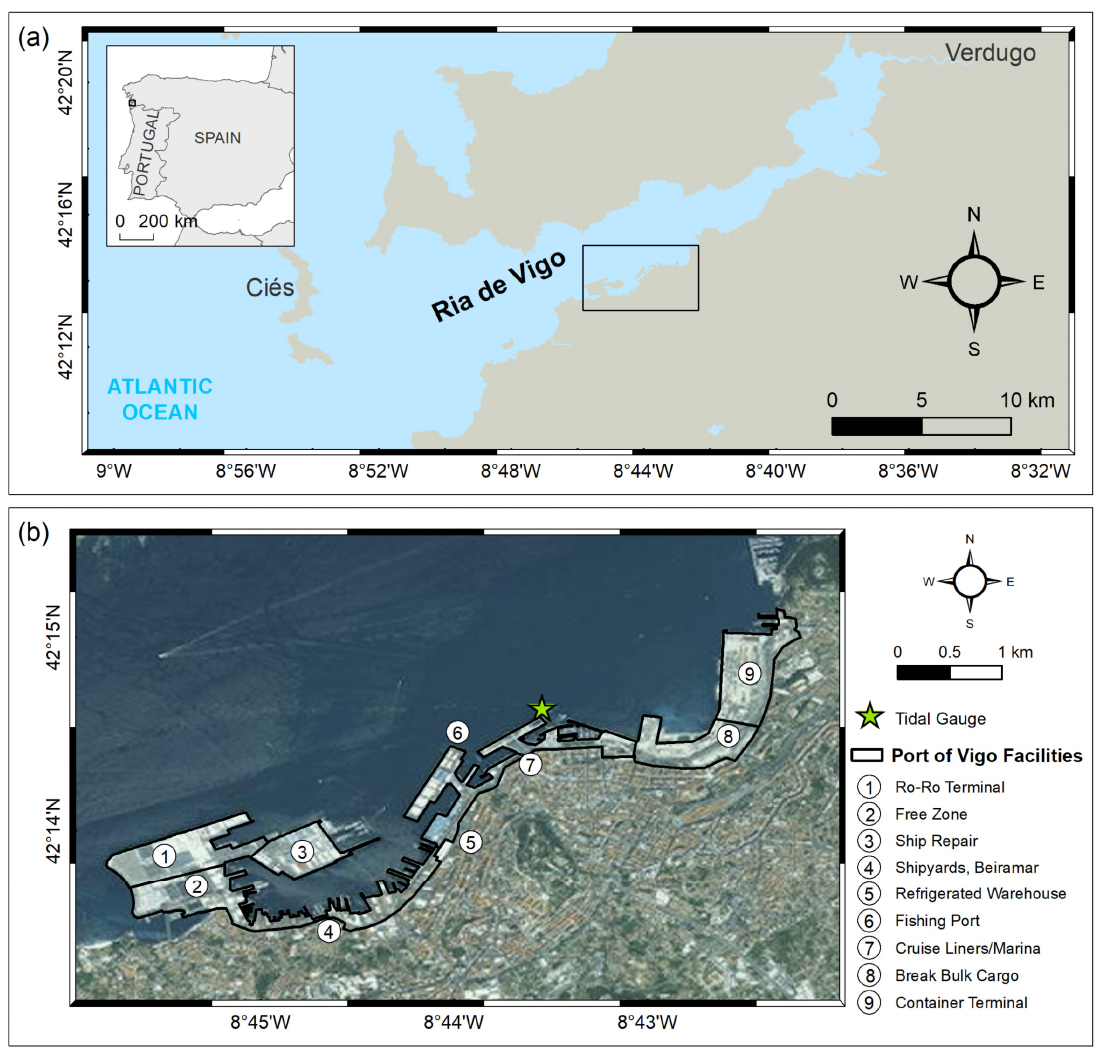
Figure 3. Study area with the in-situ stations ( a ) used to validate the hydrodynamic model (data retrieved from [62]). Location of the Vigo port and the business areas in the port administration jurisdiction ( b ).